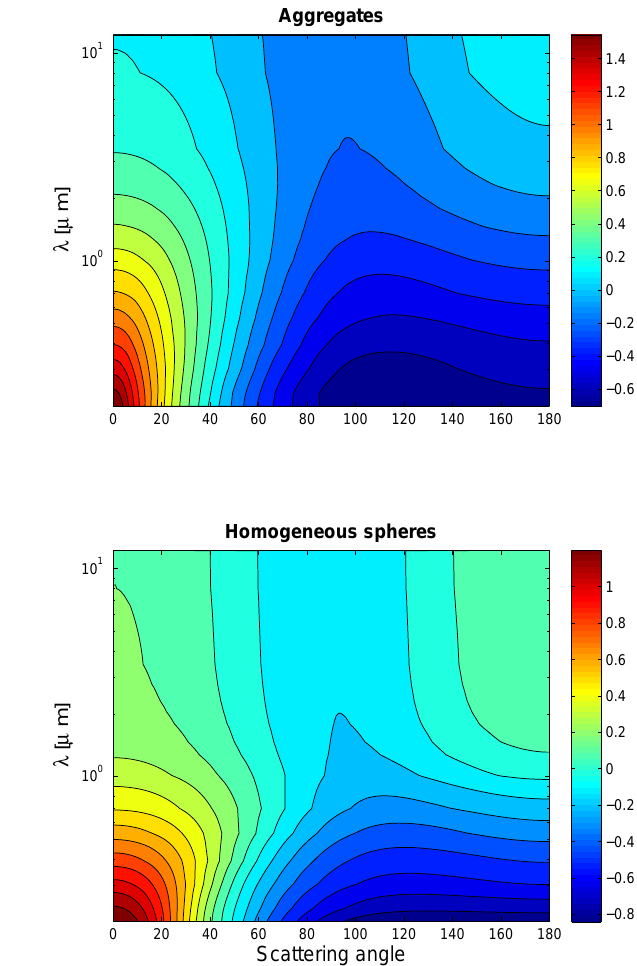
Fig. 4. Phase function p λ (2) as a function of scattering angle 2 and wavelength λ . The phase functions are computed with the aggregate model (top) and the HSA (bottom), and size-averaged over a log- normal